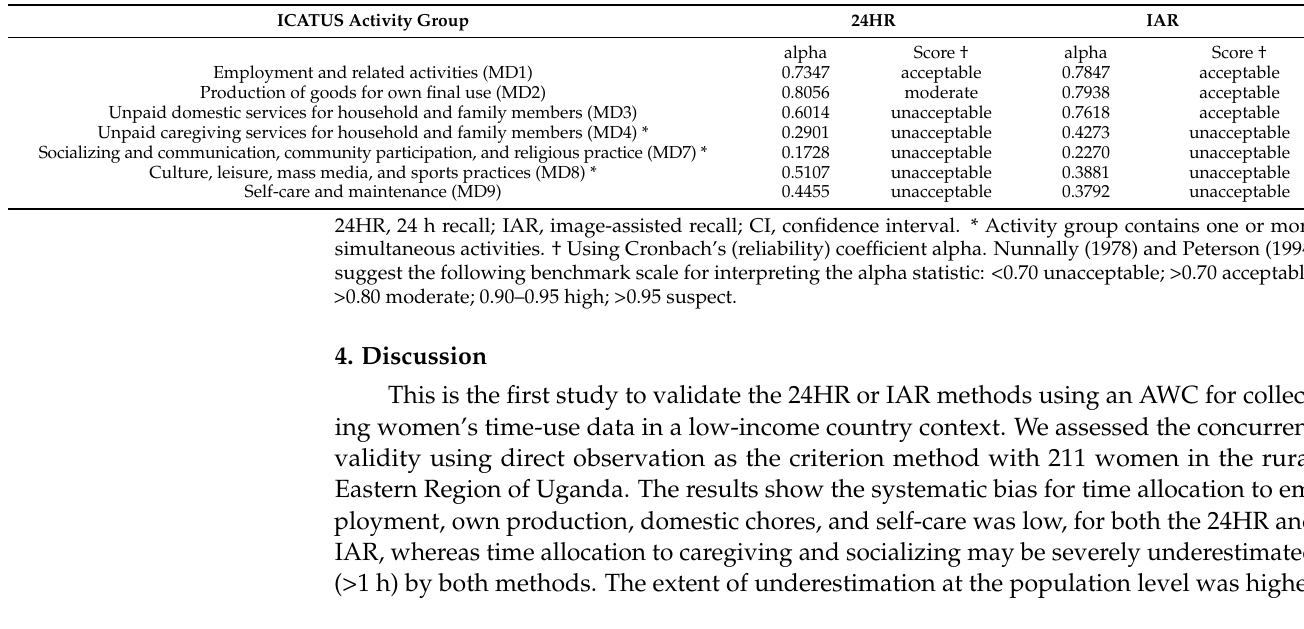
Table 4. Inter-method comparison of reliability for time Table 4. Inter ‐ method comparison of reliability for time allocation.